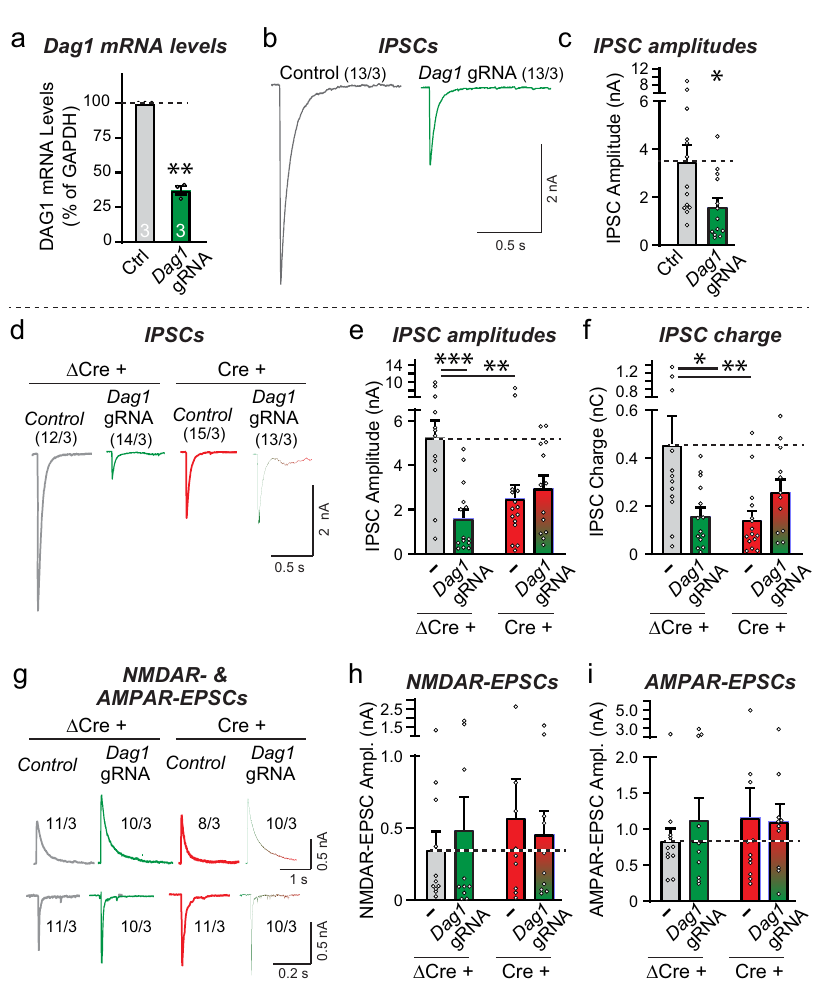
Fig. 6 | CRISPRi-mediated inhibition of dystroglycan expression in dissociated OB neurons suppresses inhibitory but not excitatory synaptic transmission, with the Nrxn3 and dystroglycan manipulations each occluding the other ’ s phenotype. a – c CRISPR interference (CRISPRi)-mediated inhibition of dystrogly- can( Dag1 )expressiondecreasesthelevelsofdystroglycanmRNAsandsigni fi cantly decreases the amplitude of evoked IPSCs ( a , qRT-PCR measurements of Dag1 mRNA levels; b , sample traces; c , summary graph of IPSC amplitudes). d – f Combined inhibition of dystroglycan ( Dag1 ) and Nrxn3 expression does not lowerthe evokedIPSC amplitudemore severelythanthe single inhibitionof either dystroglycan orof Nrxn3 expression ( d , sample traces; e , f , summarygraphs of the IPSC amplitudes ( e ) and charge transfer ( f )). IPSCs evoked by extracellular stimu- lation were recorded from mitral/tufted cells in dissociated culture obtained